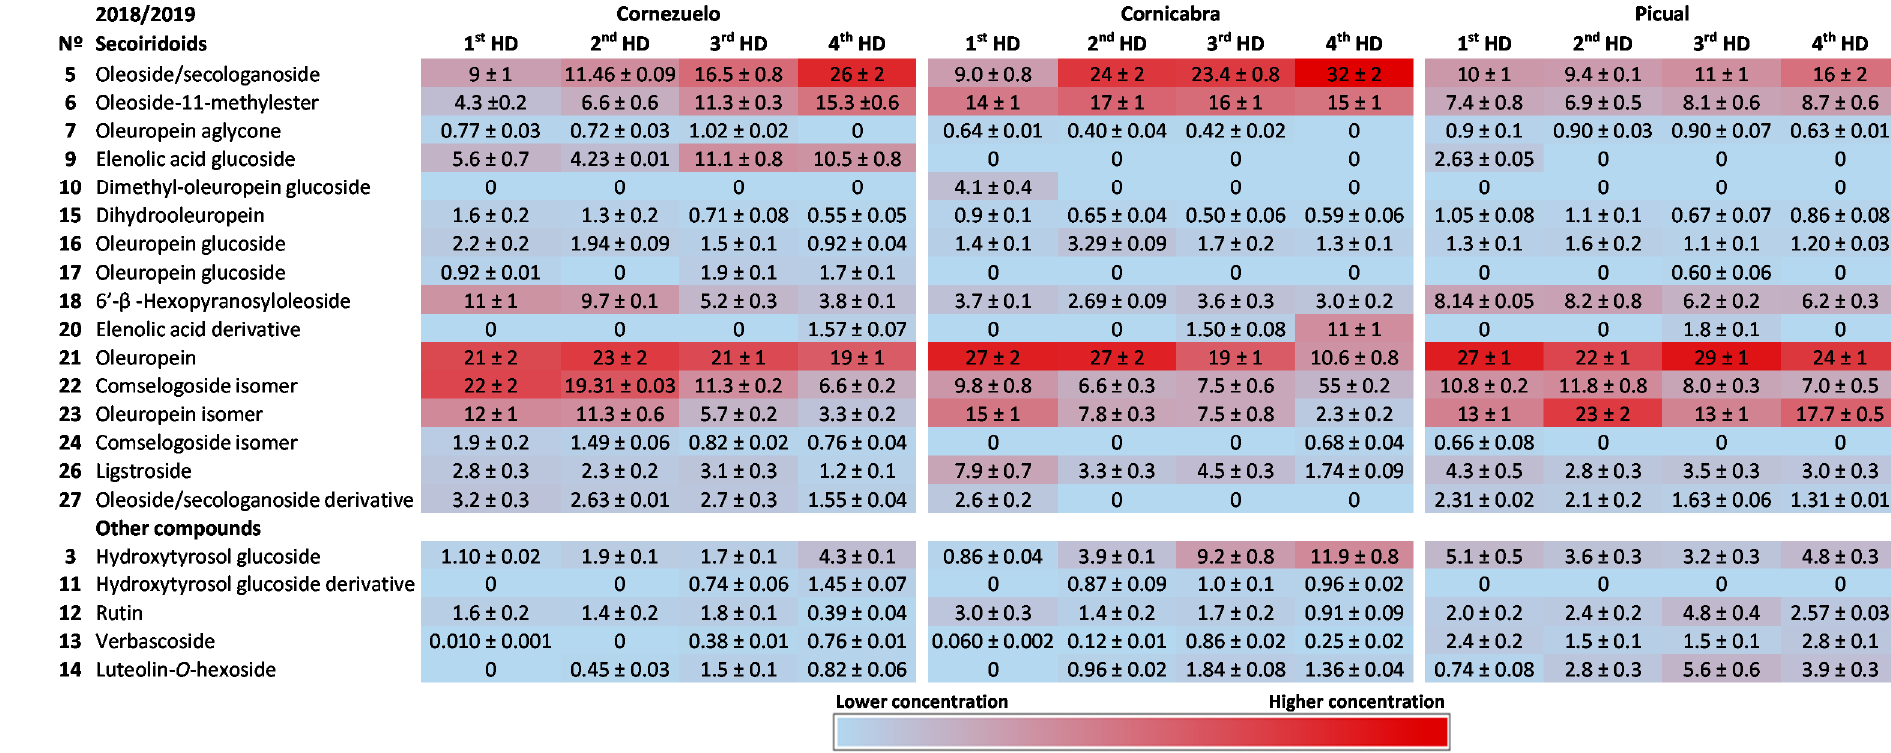
Figure 4. Heatmap showing the quantification of compounds in extracts of Cornezuelo, Cornicabra and Picual olives during the season 2018/2019 in different ripening stages using a colour scale. Data are given as percentage ± standard deviation ( n = 3).